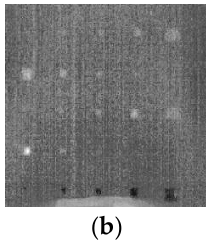
Figure 9. The EOFs obtained through PCT. ( a ) The 2nd EOF; ( b ) the 3rd EOF.